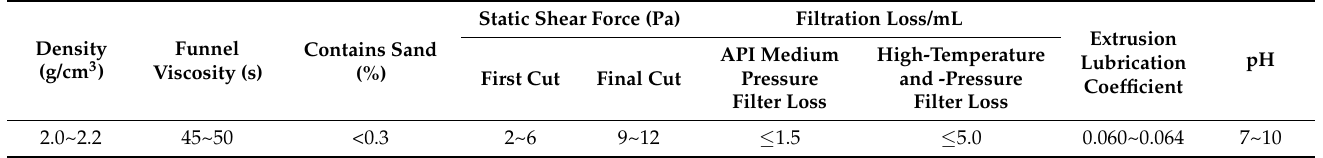
Table 3. Field water-based drilling fluid performance.